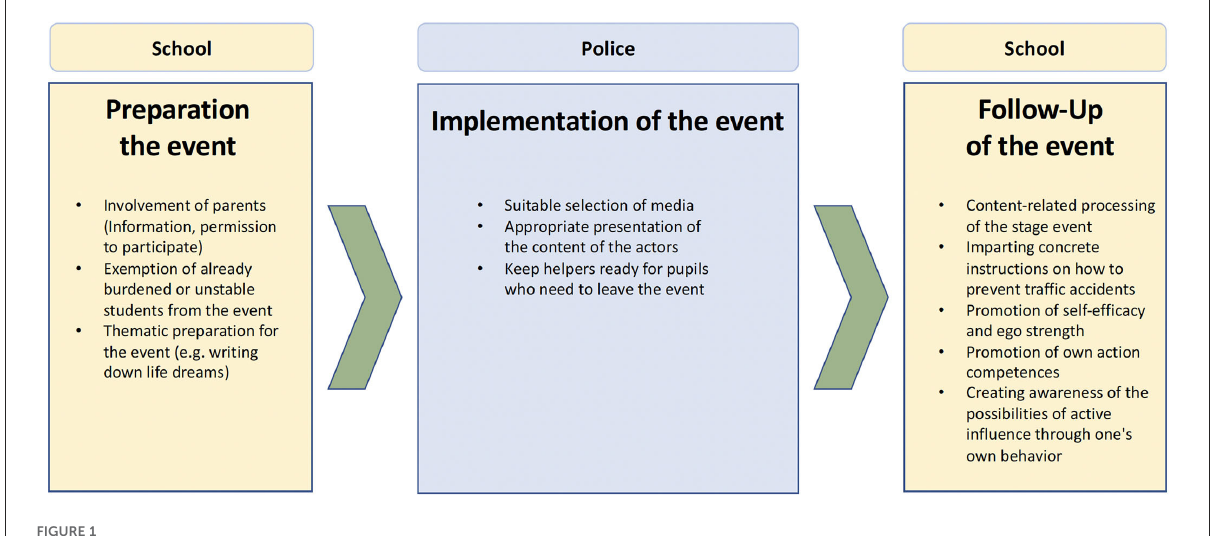
FIGURE1 Overview of the phases of action of the Crash Kurs NRW.